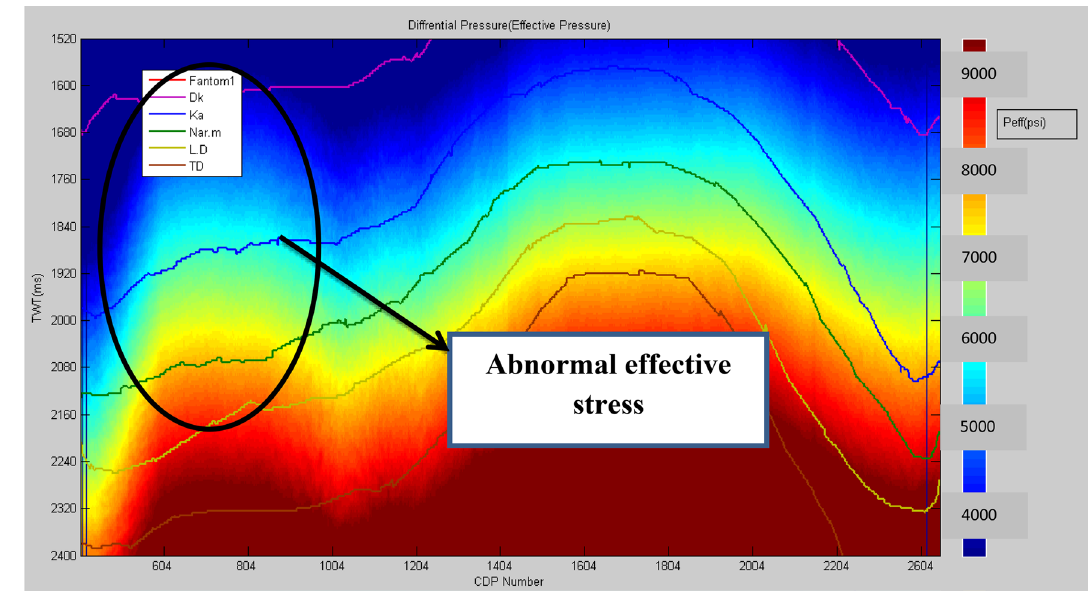
Fig. 6 Converted effective pressure of Sefid-Zakhor obtained by the velocity model. Effective pressure increases with a depth around the well No. 1. The abnormal effect is obvious on the left-hand side Fig. 7 Interval velocity and effective pressure relation as = aP b Bowers equation: V int